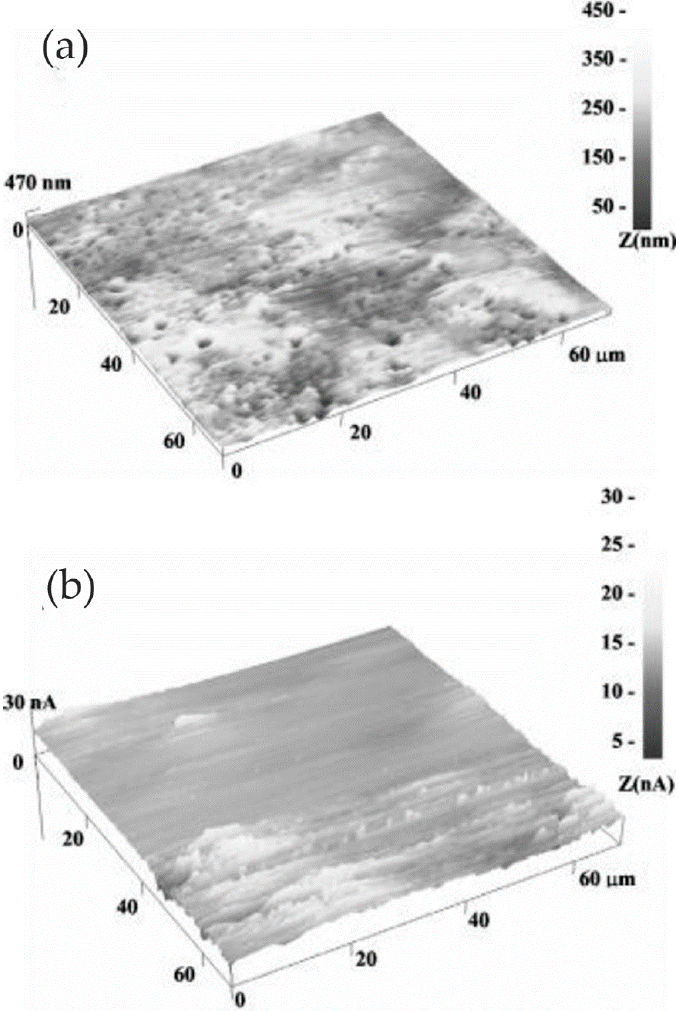
Figure 15. EC-AFM/scanning electrochemical microscopy (SECM) images of AA1050 in 10 mM NaCl+ 5 mM KI at 300 mV anodic polarization, and tip at +750 mV vs. Ag/AgCl: ( a ) topography; ( b ) electrochemical activity map. Adapted with permission from Reference [50]; copyright 2005 Electrochemical Society.